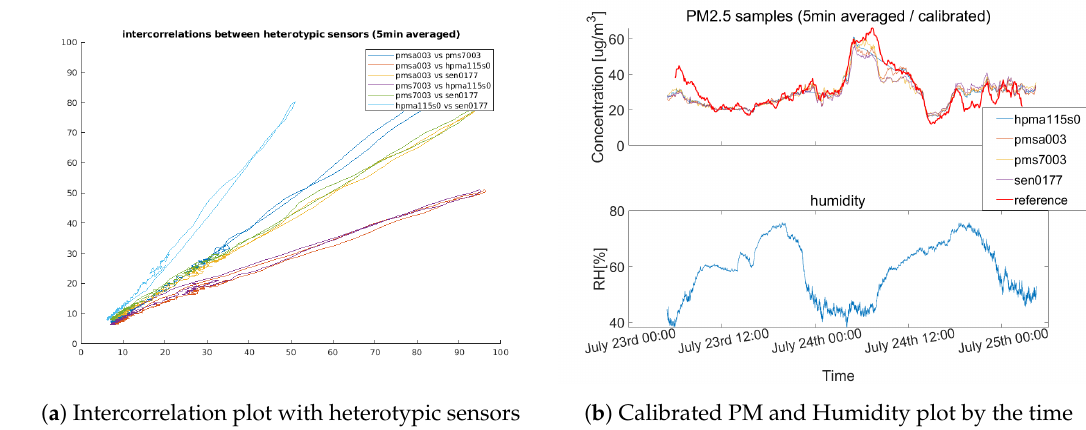
Figure A5. Prototypes output